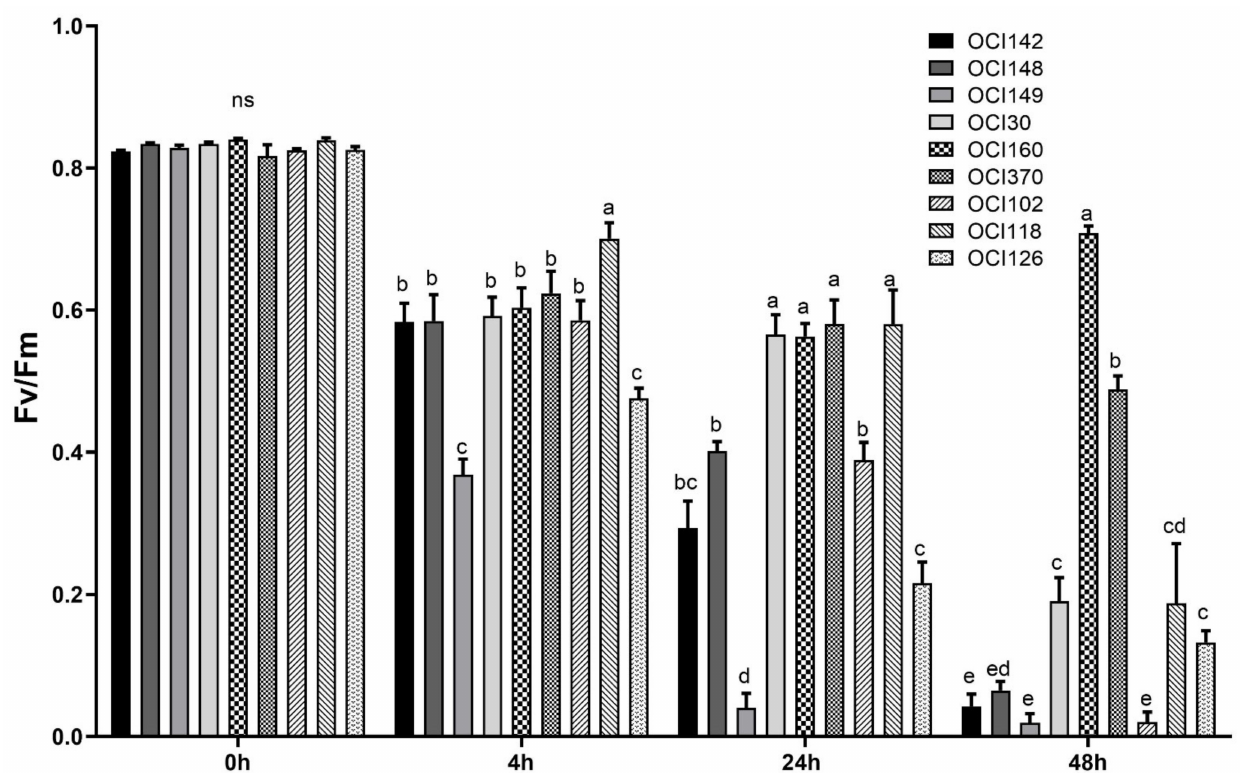
Figure 2. Time course of maximum quantum efficiency of photosystem II, (Fv/Fm) measured in leaves of nine different sweet basil ecotypes exposed to UV-B light (68 kJ m − 2 day − 1 ) or not exposed (0 h). The measurements were carried out at 0, 4 h, 24 h, and 48 h after the end of the UV-B exposure. Data are shown as means with at least five independent biological replicates and error bars indicate standard error. Data were subjected to analysis of variance and differences were analyzed by Tukey’s posttest. Different letters denote significant differences at p < 0.05 (ns: not